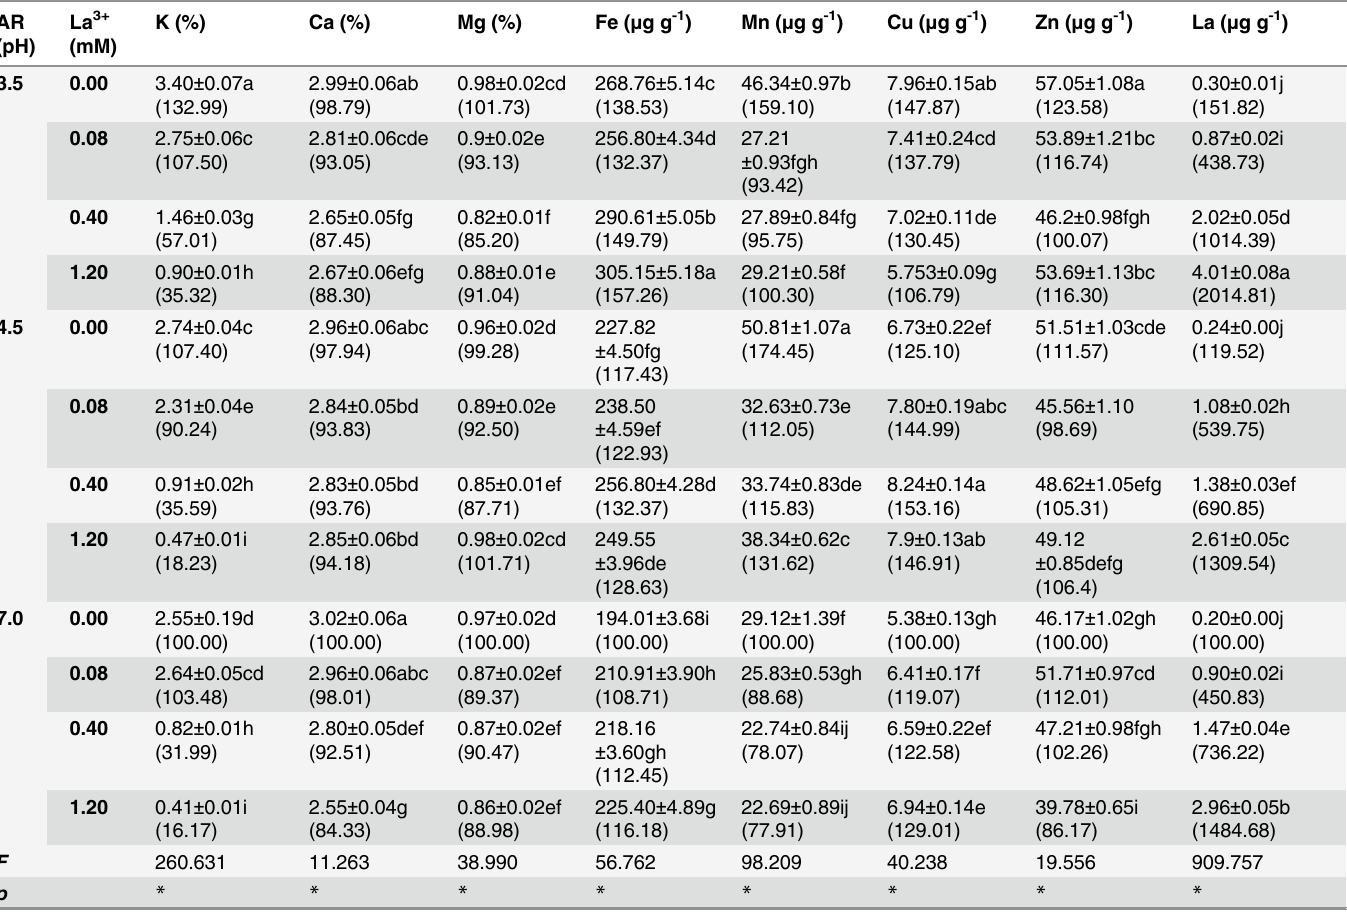
a Values are means ± standard deviation errors, n = 5. b Signi fi cantly differences at p < 0.05 were showed with different letter in each column. * Signi fi cance at 0.05